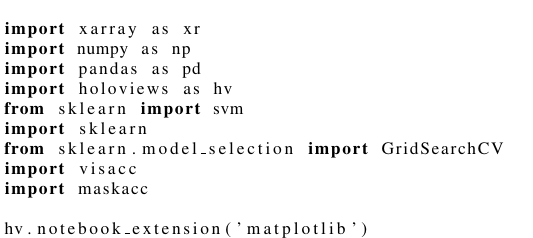
Figure 1. Importing all necessary packages and declaring that Holoviews should use Matplotlib